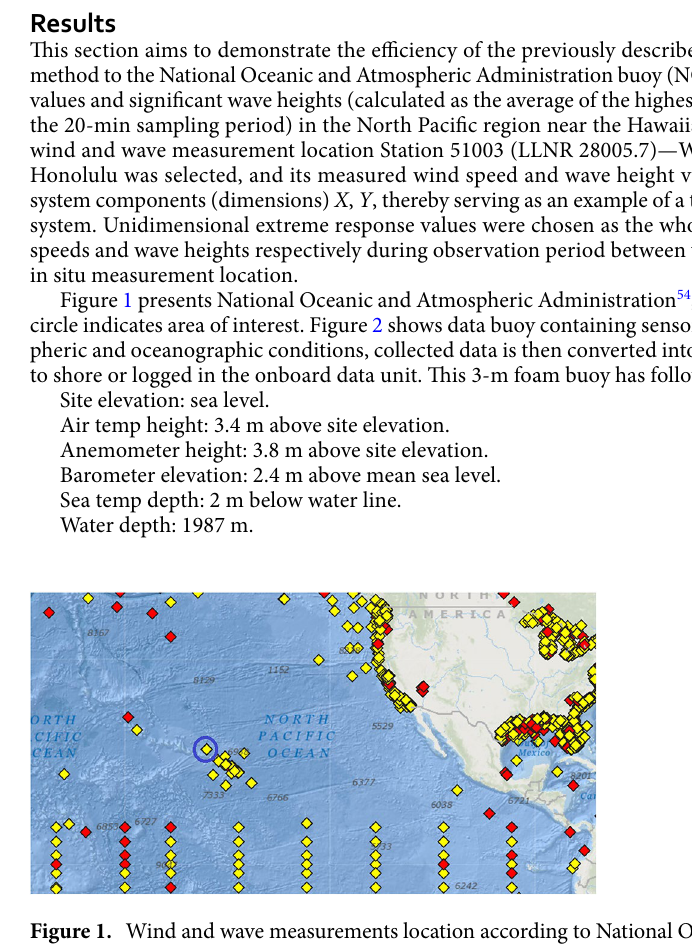
Figure 1. Wind and wave measurements location according to National Oceanic and Atmospheric Administration, blue circle indicates measurement station of interest. Figure taken from National Oceanic and Atmospheric Administration, https:// www. ndbc. noaa.